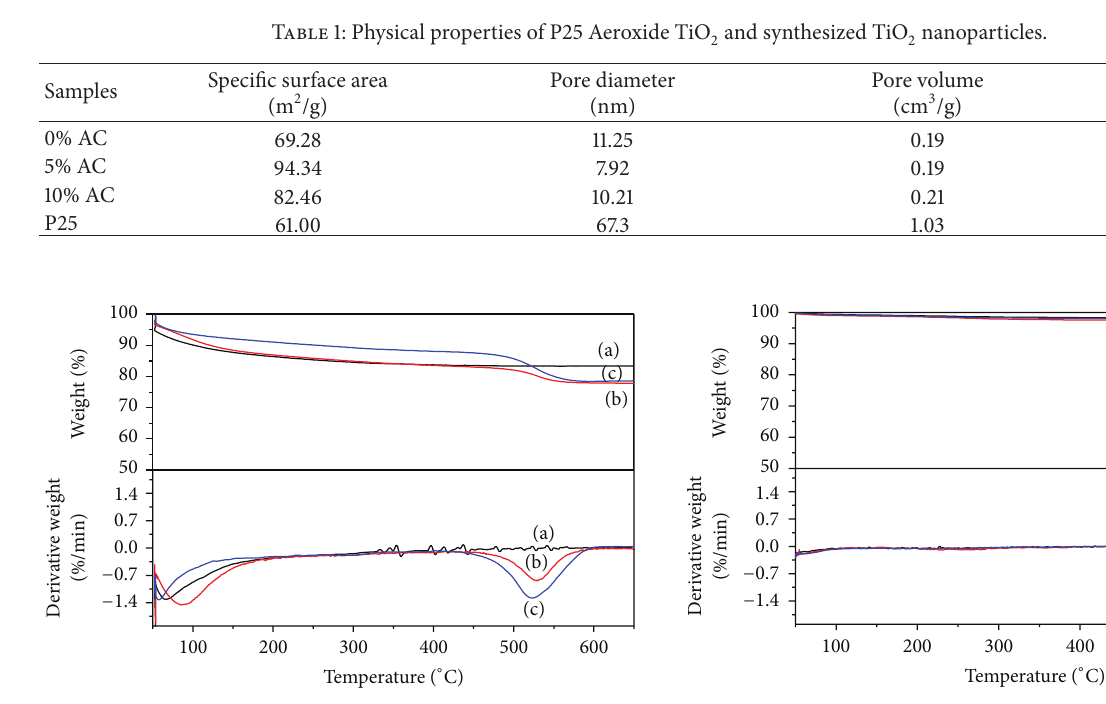
Figure 2: TGA-DTA of synthesized TiO 2 nanoparticles using an activated carbon template in different quantities and with no calcination: (a) 0%, (b) 5%, and (c) 10%.